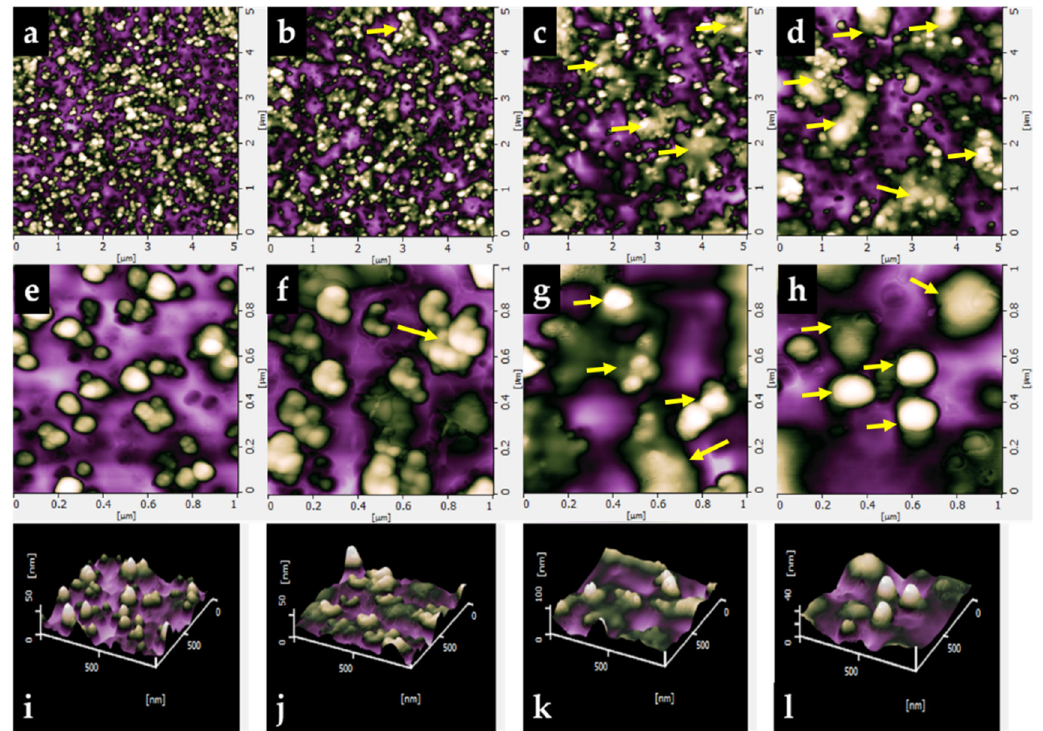
Figure 1. AFM micrographs of ( a ) N115/NR, ( b ) N330/NR, ( c ) N550/NR, and ( d ) N660/NR, ( e – h ) are the enlarged area AFM images of ( a – d ), and ( i – l ) are the three-dimensional surface morphologies of the corresponding ranges.